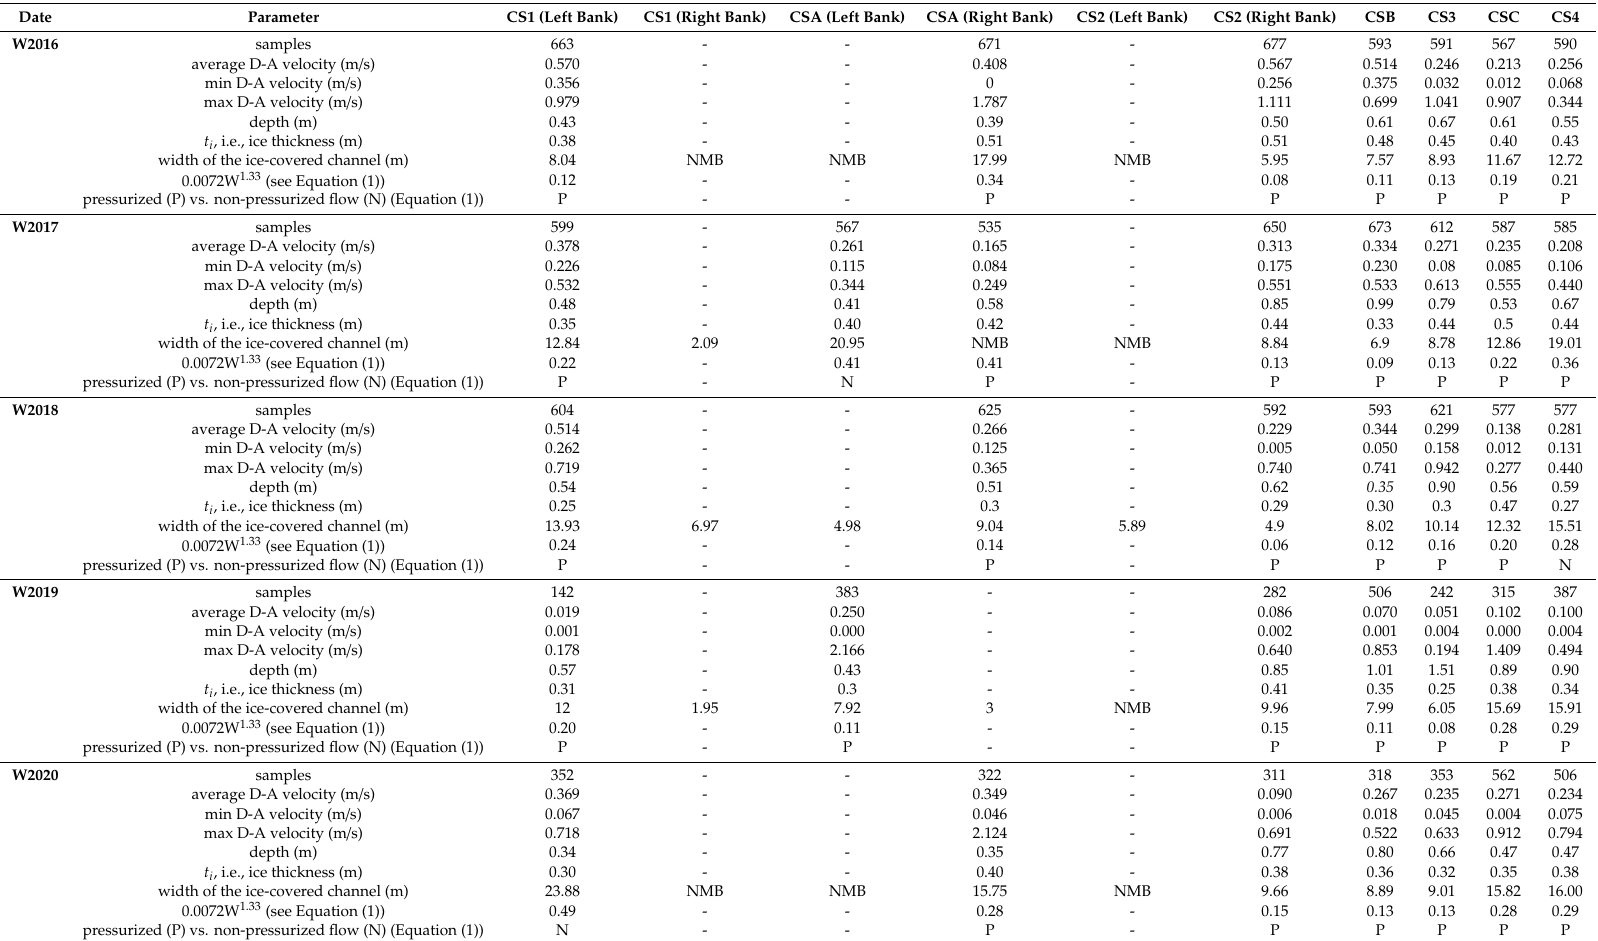
Table 3. The basic flow characteristics of each of the analyzed ice-covered measurements from their measurement location (see Figures 1 and 2) within cross-sections (CS). The average, minimum, and maximum values of depth-averaged (D-A) velocities were defined. In some winters the CS1, CSA, and CS2 had mid-channel bars, where the ice was bottom-fast (i.e., reached the riverbed). During those winters, the channel width was measured from both sides (left and right bank) of the mid-channel bars. NMB = no mid-channel